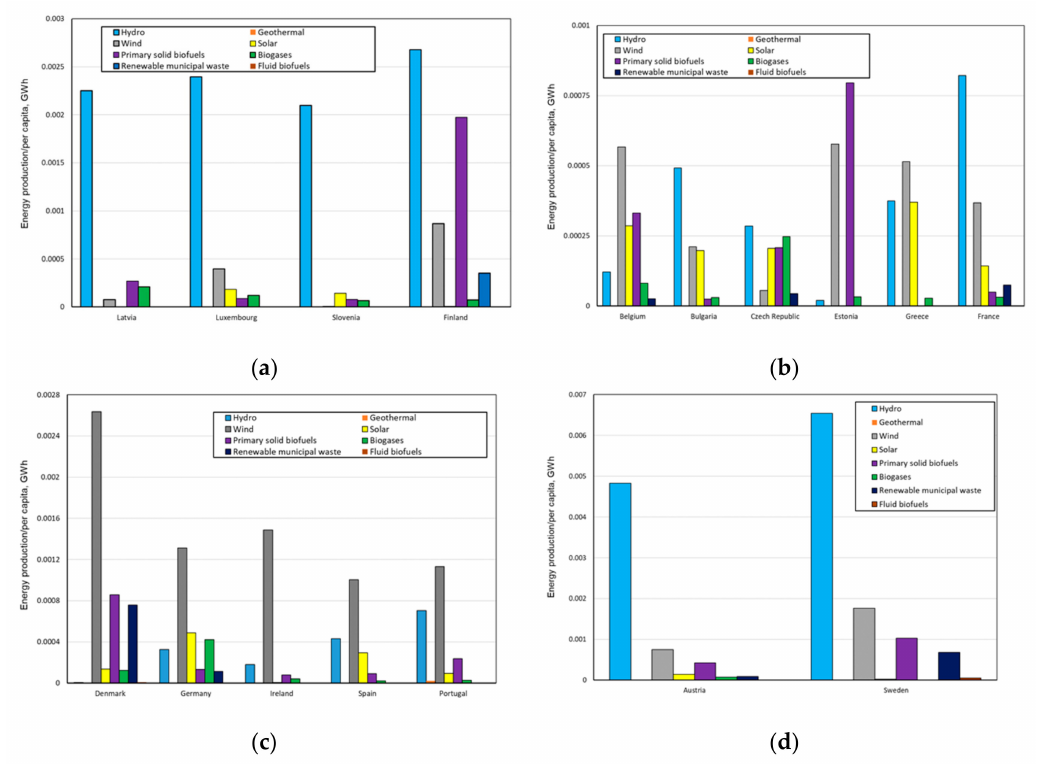
Figure 14. The structure and volume of energy production from renewable energy sources per capita by countries in individual clusters; cluster 1 ( a ); cluster 2 ( b ); cluster 3 ( c ); cluster 4 ( d ) (own study).